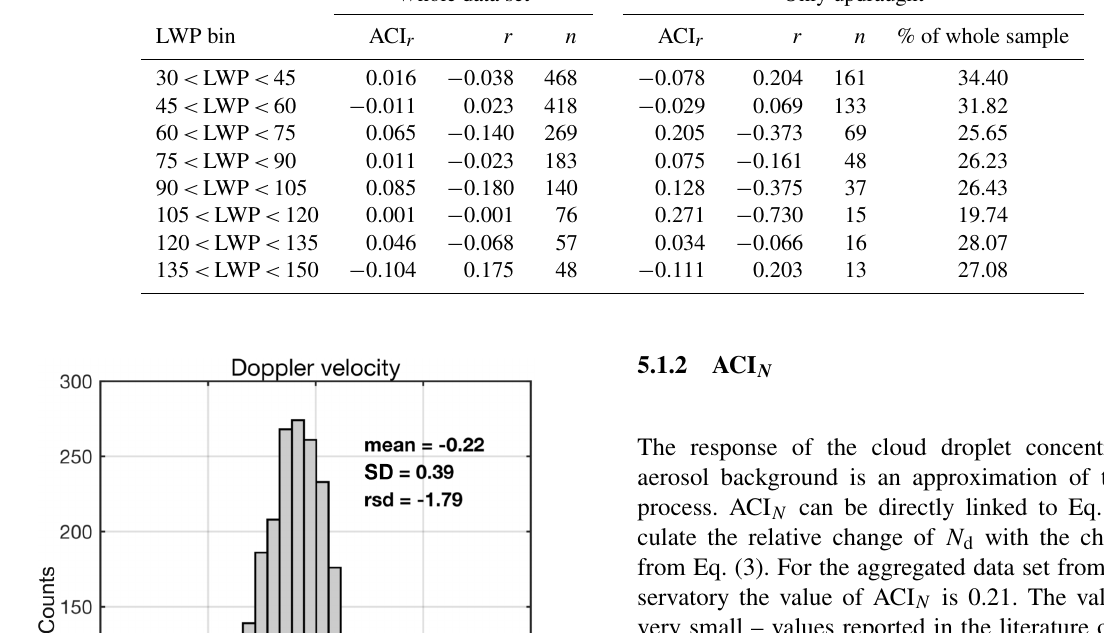
Table 2. ACI r (Eq. 4) together with Pearson product–moment correlation coefficient, r , calculated between ln( r e ) and ln(ATB) calculated for the aggregated data set. Data are divided in to bins of LWP. ACI r is calculated for the whole data set and only for the updraught areas. The number of measurements in each bin ( n ) and the percentage of data available for the updraught only areas are also presented. Whole data set